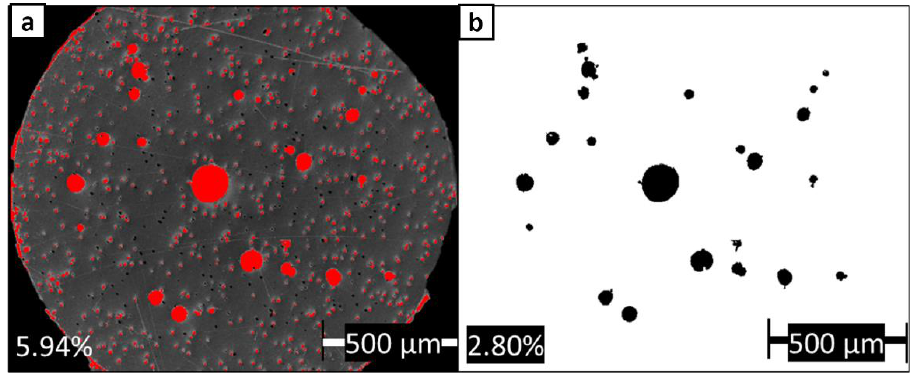
Figure 7. Example of identifying porosity in a printed sample with ImageJ software (ABS w/5%CF with 2 mm print layer height is shown). ( a ) is the as-taken optical image, and ( b ) shows the identified porosity in red.